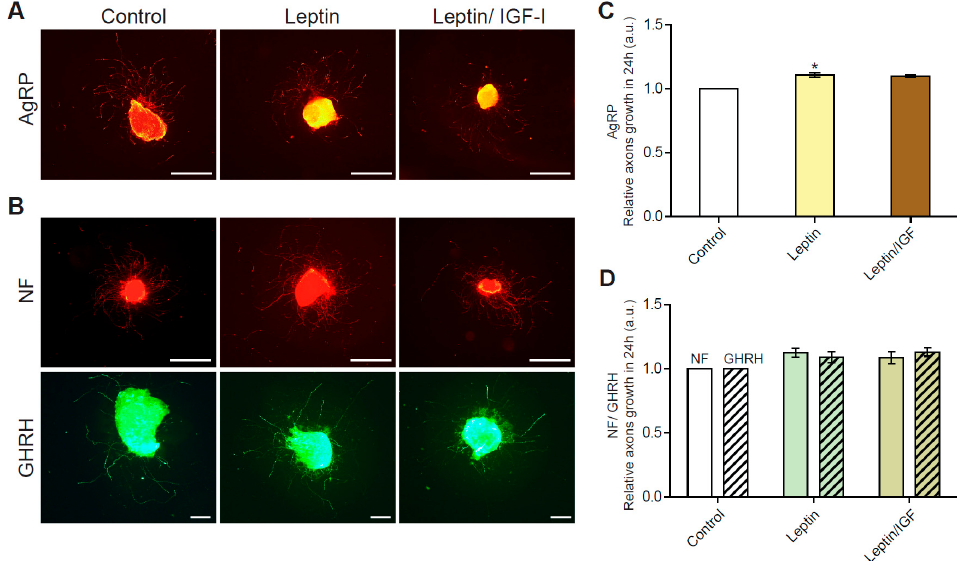
Figure 4. GHRH neurons from underfed pups are resistant to leptin for the stimulation of axon growth. ( A ) Illustrative IHC of arcuate nucleus explants from the hypothalamus micro-dissected from one-week-old underfed pups in control conditions (left panel), and after stimulation with leptin alone (middle panel), or with leptin/IGF-1 (right panel), with AgRP axons labeled in orange. ( B ) Axons from total arcuate nucleus neurons and GHRH neurons labeled by dual-IHC for neurofilament (NF, in red) and eGFP (in green), respectively. Scale bars represent 1000 µm for AgRP+ and NF+ IHC (4X magnification) and 200 µm for GHRH+ IHC (10X magnification), on images from an Olympus BX612 fluorescence microscope equipped with a DP71 CCD camera. ( C ) Quantification of the growth of AgRP axons stimulated by incubation for 24 h with leptin or leptin/IGF-I, relative to control conditions ( n = 5 experiments), and ( D ) quantification of the growth of NF (plain bars) and GHRH (dashed bars) axons ( n = 6 experiments). Data are presented as the mean ± SEM. Results were compared in a one-way ANOVA with the Newman–Keuls post hoc test (c) or in a two-way ANOVA with Bonferroni correction (d), with *: p <